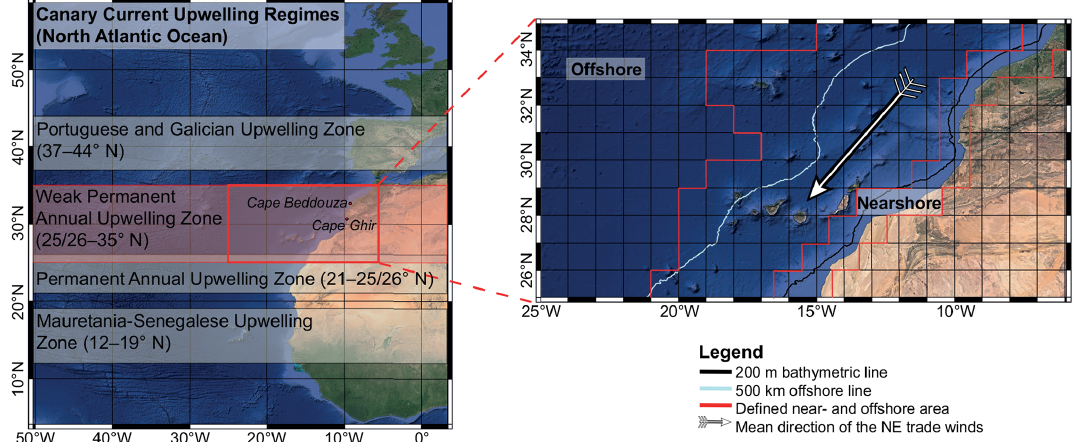
Figure 3. Upwelling regimes in the Canary Current upwelling systems and the nearshore area of the study region (modified after Arístegui et al., 2009; Cropper et al., 2014; © Google Earth 2022).